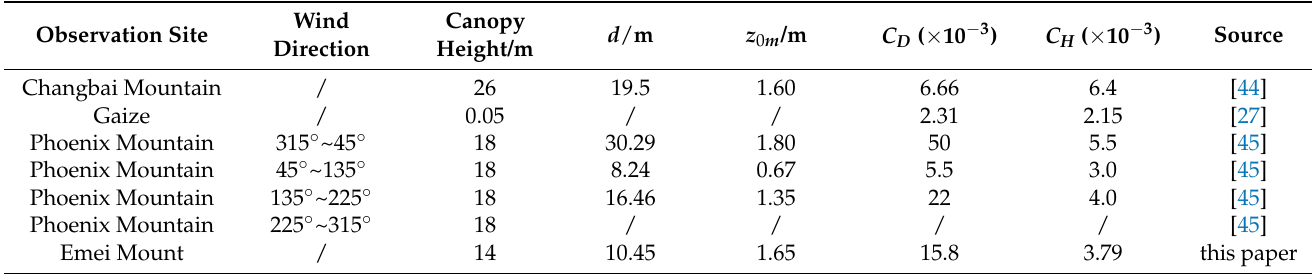
Figure 4. ( a ) Annual distribution scatter diagram of C D ; ( b ) monthly average variation diagram of C D ; ( c ) scatter diagram of C D varying with wind speed; ( d ) annual distribution scatter diagram of C H ; ( e ) monthly average variation diagram of C H ; ( f ) scatter diagram of C H varying with wind speed. Table 1. Comparison of overall transport coefficient under different underlying